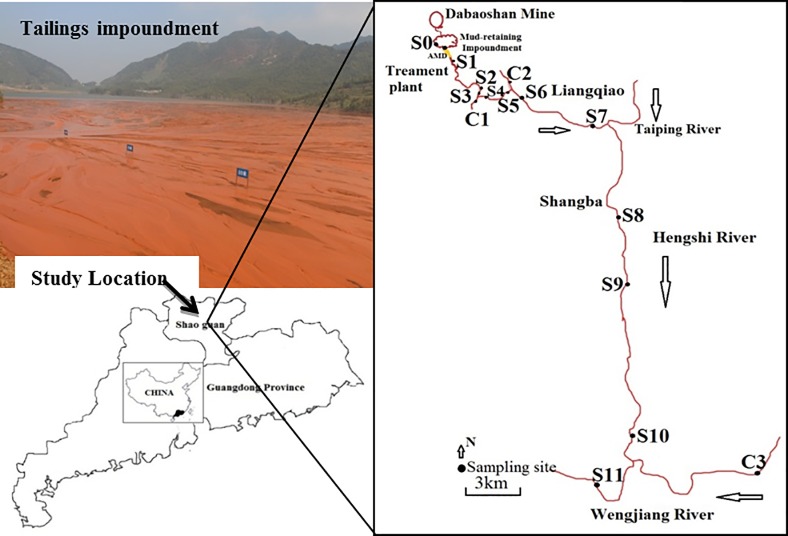
Map showing the locations of studied area of Dabaoshan Mine.(● represented the sample sites; S0 was tailings impoundment; the S1 to S11 located in the Hengshi River affected by AMD; C1 to C3 were control sites located in the tributaries).